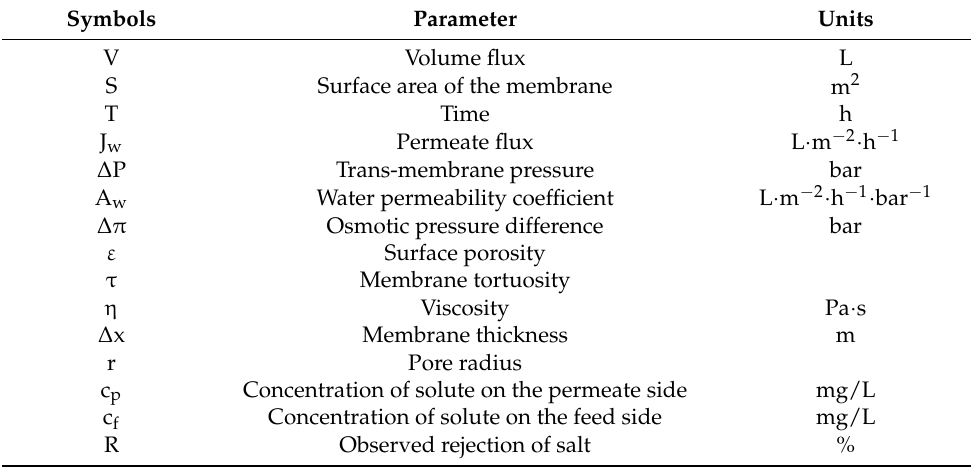
Table 2. Symbols and